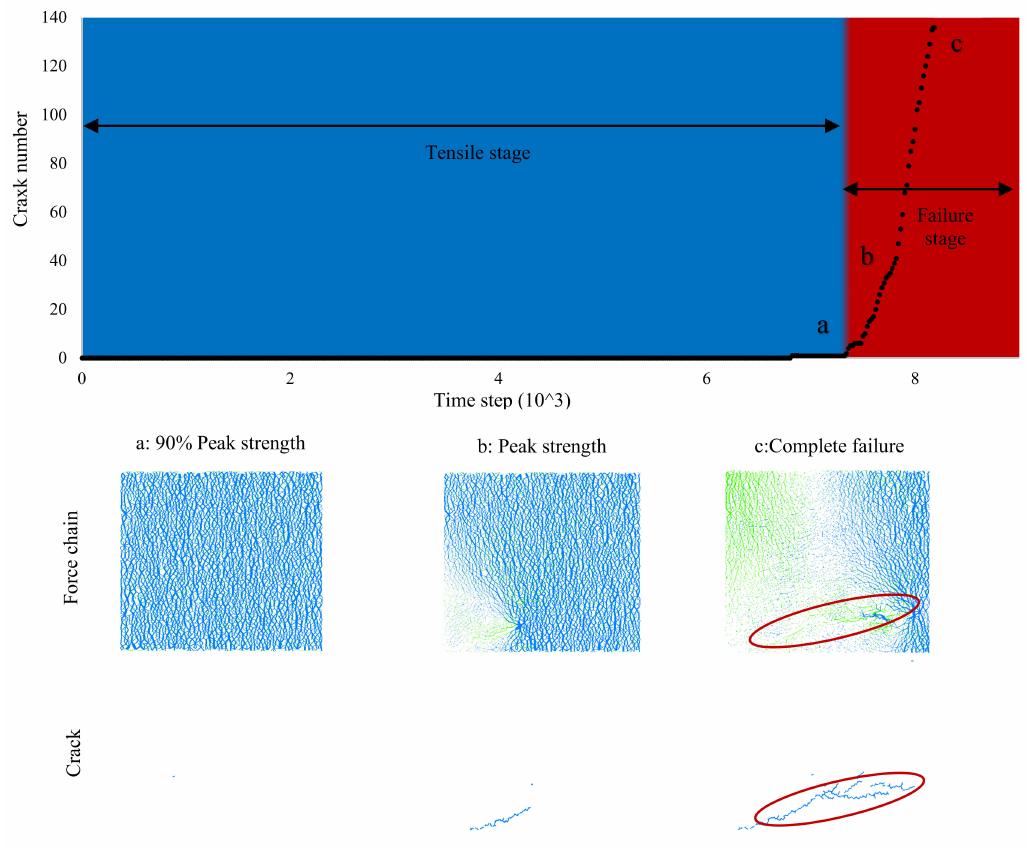
Figure 10. Force chain and crack development of 0.5% biopolymer treated sand under the tensile